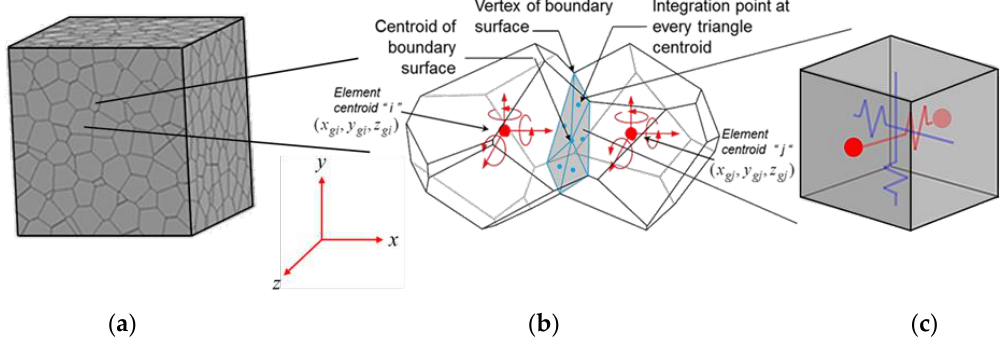
Figure 2. Depiction of 3D-RBSM (Rigid Body Spring Model) for modeling of concrete; ( a ) Discretization of concrete using Voronoi diagram; ( b ) Illustration of integration points on the boundary interface of rigid particles; ( c ) Representation of normal and shear springs [44]. The springs are defined on the integration points as depicted in Figure 2. The integration points are produced through the division of the surface of rigid particles into sets of triangles. As shown in Figure 2, the geometric centroid of each triangle is corresponding to one integration point.